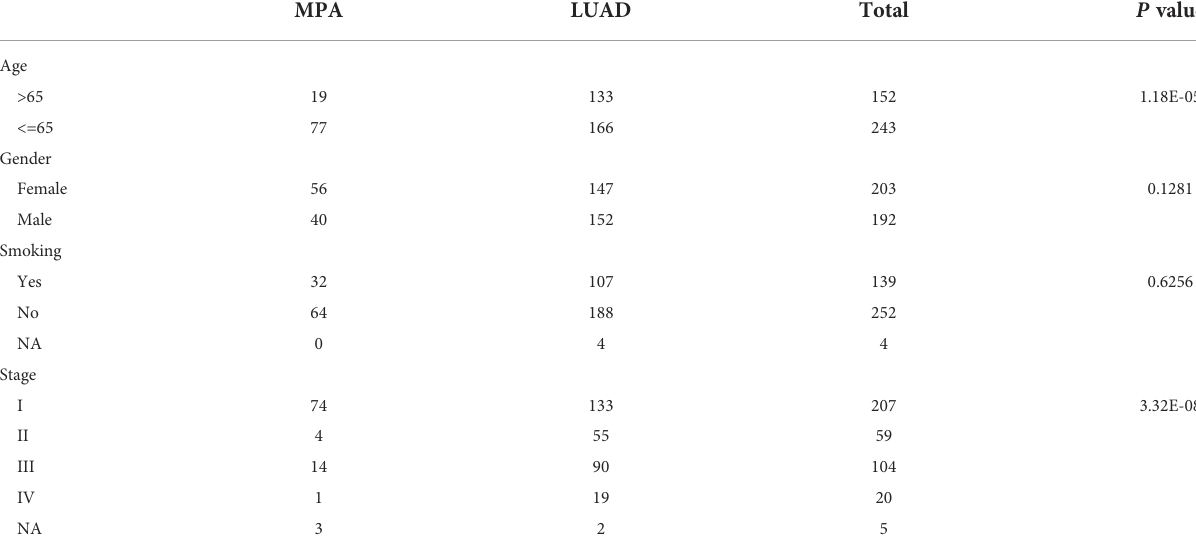
TABLE 1 The clinicopathological information of mucin-producing adenocarcinoma of the lung (MPA) and lung adenocarcinoma (LUAD).